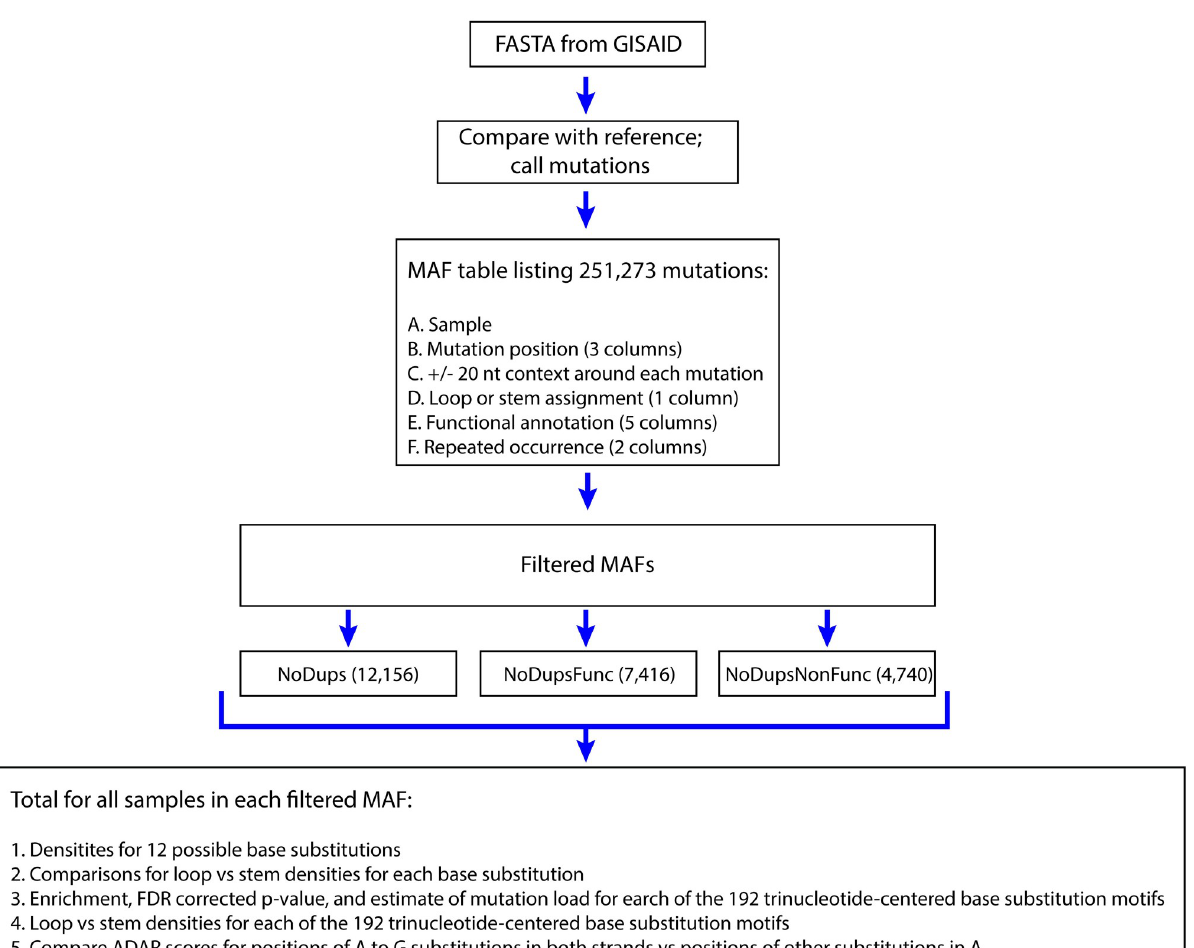
Fig 1. Analysis workflow. MAF–mutation annotation format table. Each filtered MAF combines mutations from all samples into a single dataset. Details of mutation call filtering and grouping as well as abbreviations are explained in the text of the "Design of the analysis" section.